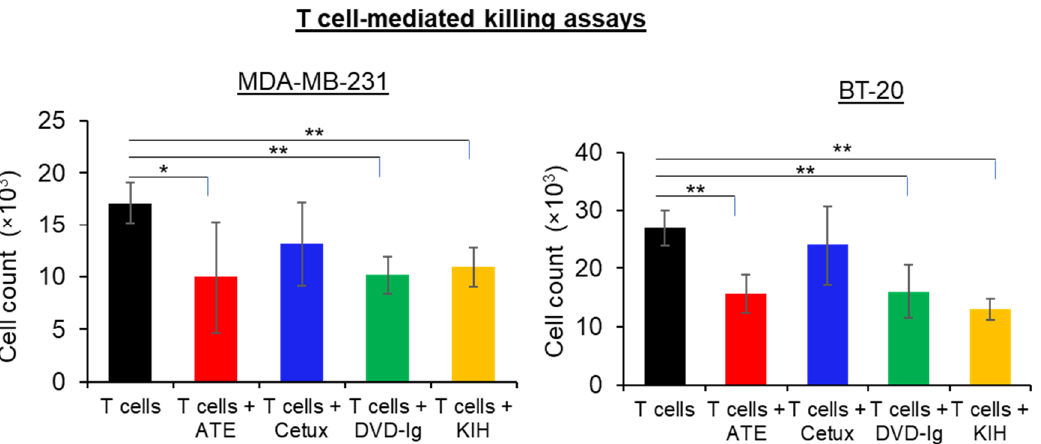
Figure 5. T cell-mediated killing assay was performed in MDA-MB-231 and BT-20 cells, in which calcein AM-labeled cancer cells were co-cultured with activated T cells, then treated with anti- EGFR/PD-L1 BsAbs, parentals mAbs or left untreated for 24 h. After 24 h of incubation, calcein AM-labeled live cells were counted by Celigo Imaging system. T cell-mediated killing assay was performed in triplicates, and data are representative of two or more independent experiments. The differences between two groups were considered statistically significant when p < 0.05 (*, p < 0.05; **, p <